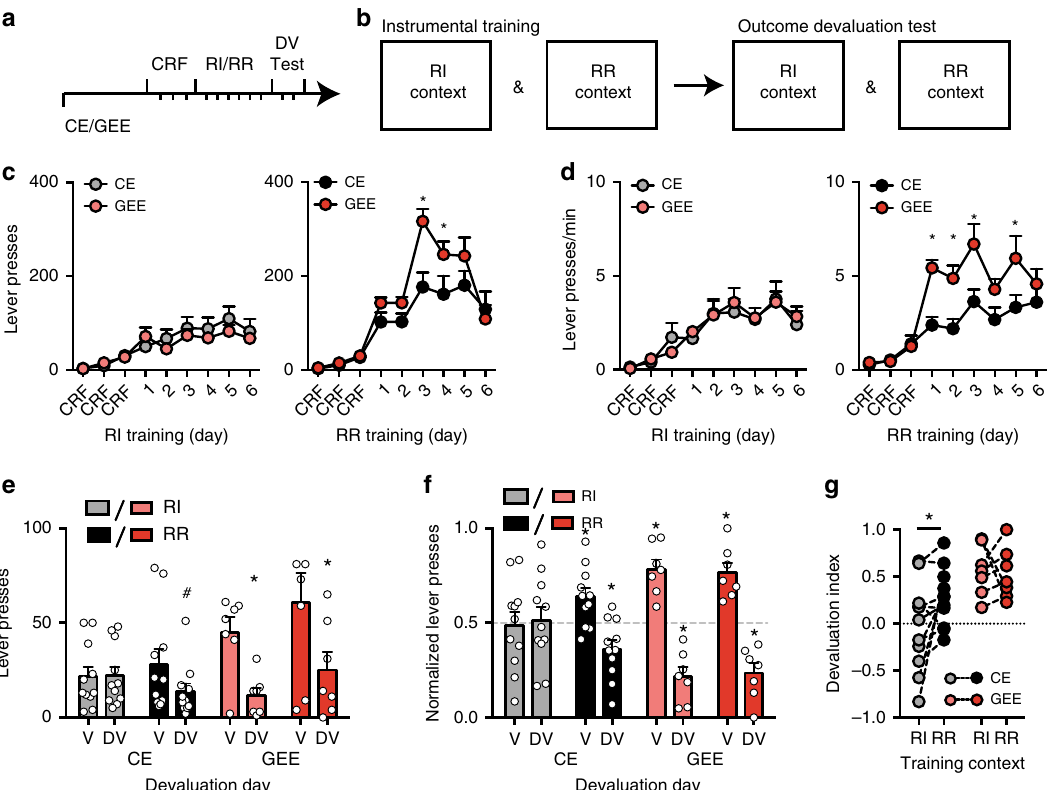
Fig. 2 Gestational ethanol exposure (GEE) disrupts cognitive function. a Schematic diagram of experimental time course. At 2 – 3 months of age a subset of mice was used for instrumental training (continuous reinforcement schedules (CRF), training under random interval (RI) and random ratio (RR) schedules, and outcome devaluation (DV) tests). b Schematic of instrumental training. Mice were trained each day in two separate operant chambers that were distinguished by contextual cues denoting either RI or RR schedules. Outcome devaluation testing occurred across two consecutive days (the valued day and devalued day), with testing occurring in each context. c Lever presses and d response rate during RI and RR schedule training for CE and GEE mice. e Lever presses and f normalized lever-pressing in RI and RR trained contexts during outcome devaluation testing in Valued (V) and Devalued (DV) states. g Devaluation index of individual mice tested under RI and RR contexts. Error bars equal ± SEM, Repeated measures ANOVA Bonferroni corrected * p < 0.05, # p <